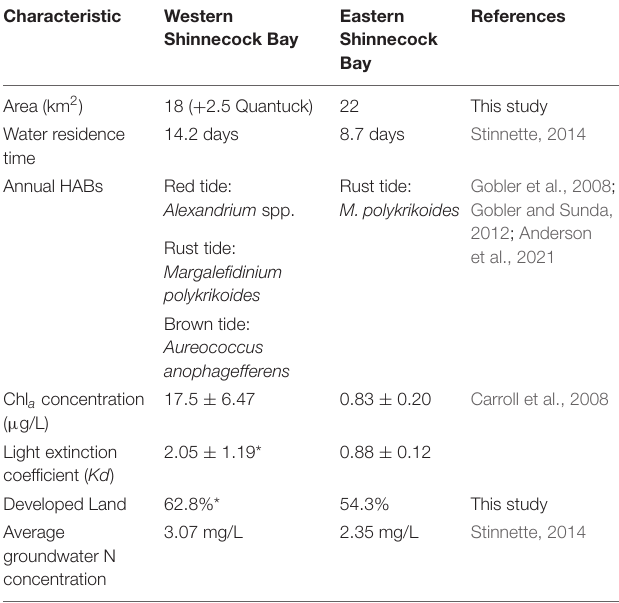
TABLE 1 | Water quality and physical characteristics of the eastern region and western region of Shinnecock Bay.